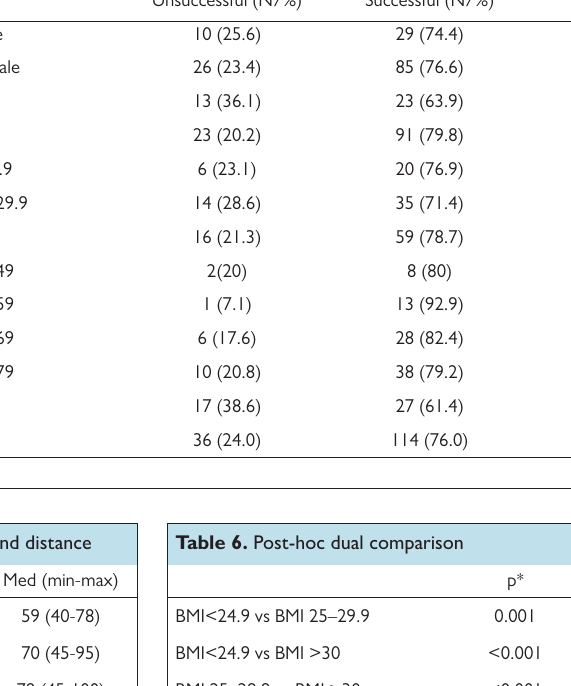
Table 2. Causes of unsuccessful procedure Number of patients Causes